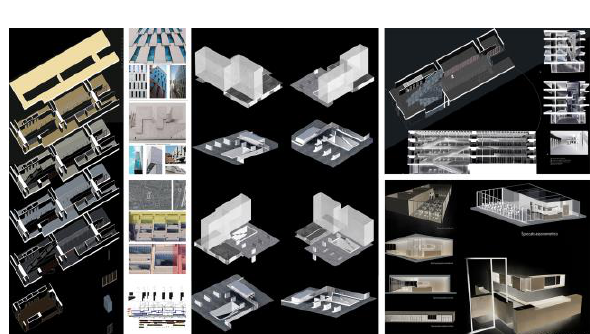
Figure 5. New Bocconi University, Milan (2008). IMC2: Formal Aspects and Internal Qualities. School of Design, Polytechnic of Milan (A. De